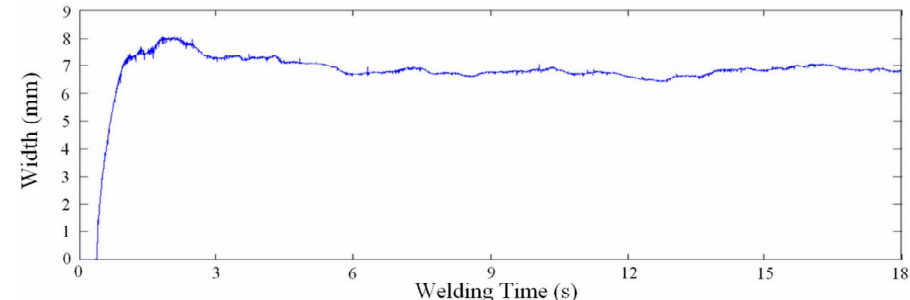
Figure 12. Real-time width measurement for a work point of 21 V and 6 m/min, using a welding speed of 10 mm/s and 100 fps as sampling rate [22].